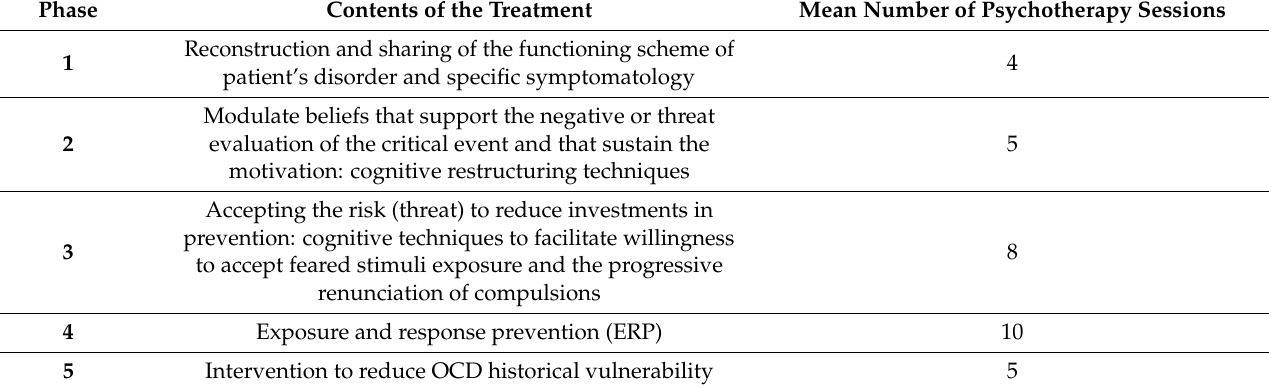
Diagrammatic Model: An example of the ABC model by Albert Ellis with beliefs pertaining to two different emotional domains